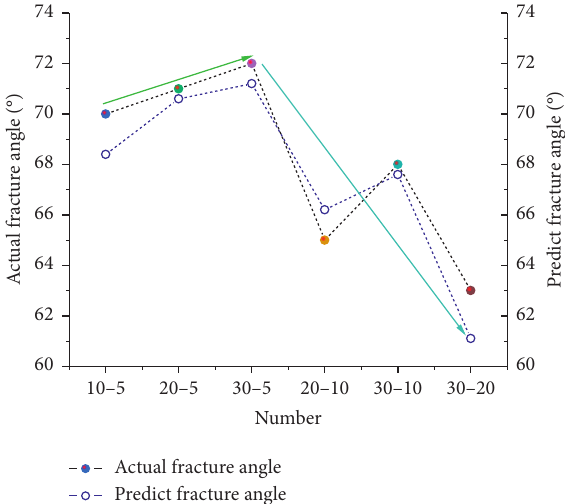
Figure 19: Relationship between the actual fracture angle and fracture trend angle under different pore water pressure and confining pressure conditions.